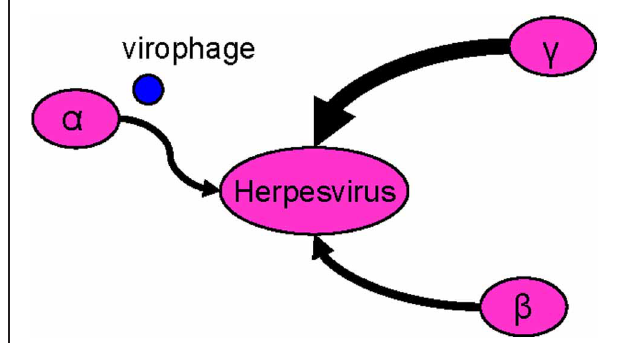
FIGURE 3 | The viral rhizome. The mammalian herpesvirus harbors genes from the α , β , and γ herpesvirus. Gene exchange often occurs by